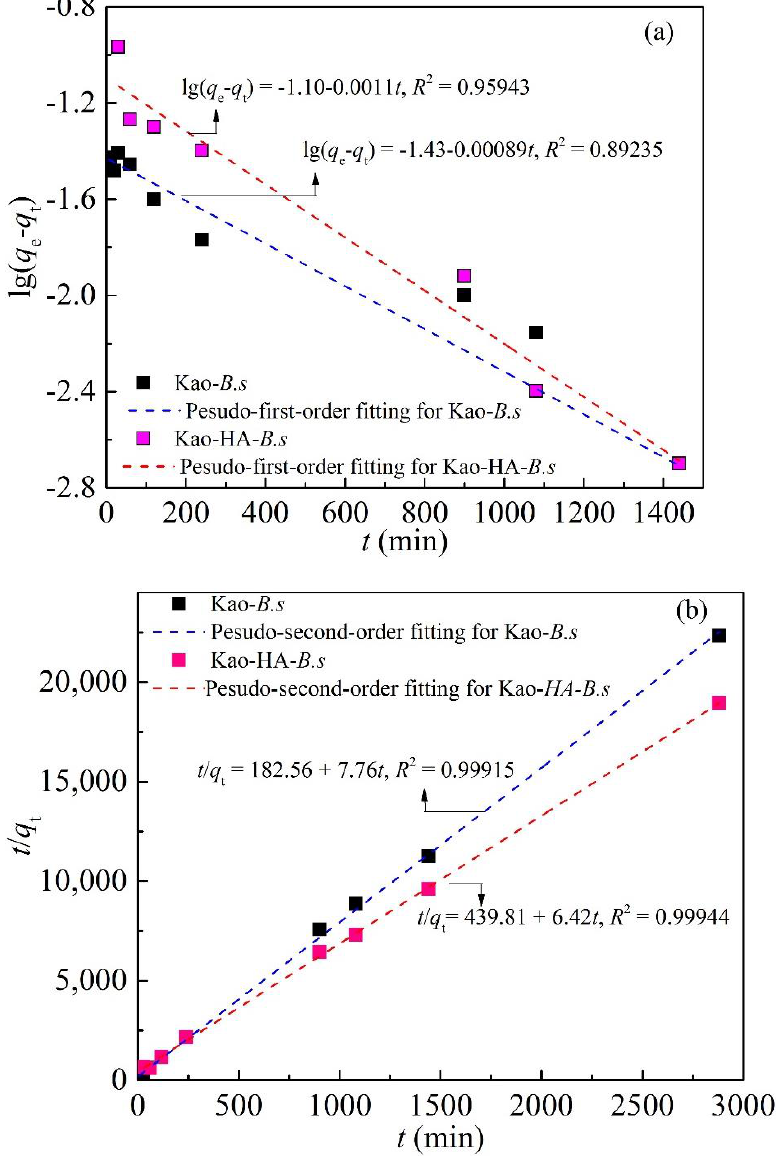
Figure 5. The adsorption kinetics of As(V) on Kao- B.s ( a ) and Kao-HA- B.s (50:1:50) ( b ) (C 0 : 1.0 mg∙L − 1 ; adsorbent dosage: 2.5 mg · L − 1 ; T: 25 ◦ C; ionic strength: 0.01 mol · L − 1 ; pH: Table 1. Adsorption kinetics parameters for As(V) on Kao- B.s and Kao-HA- B.s (50:1:50).